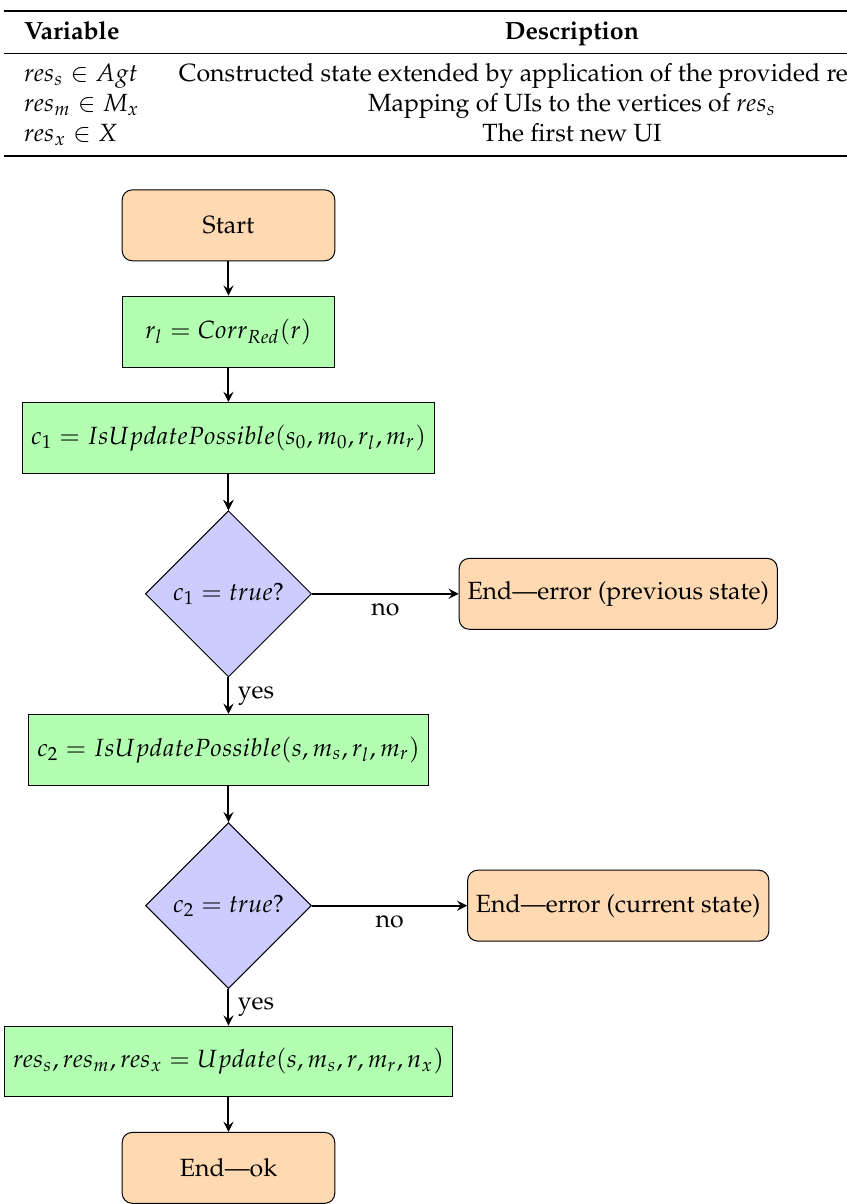
Table 6. Output data of the Phase 4